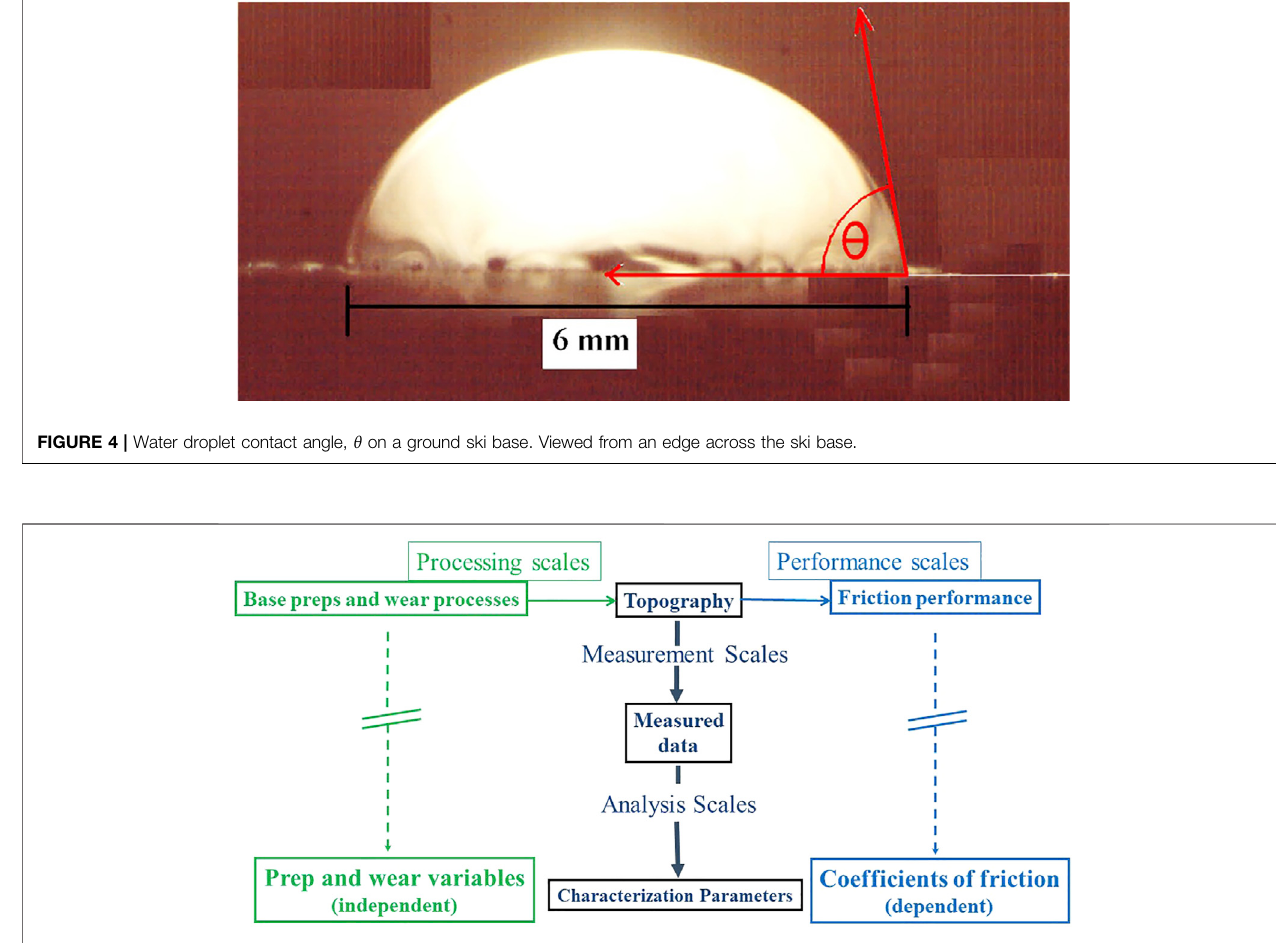
Frontiers in Mechanical Engineering |